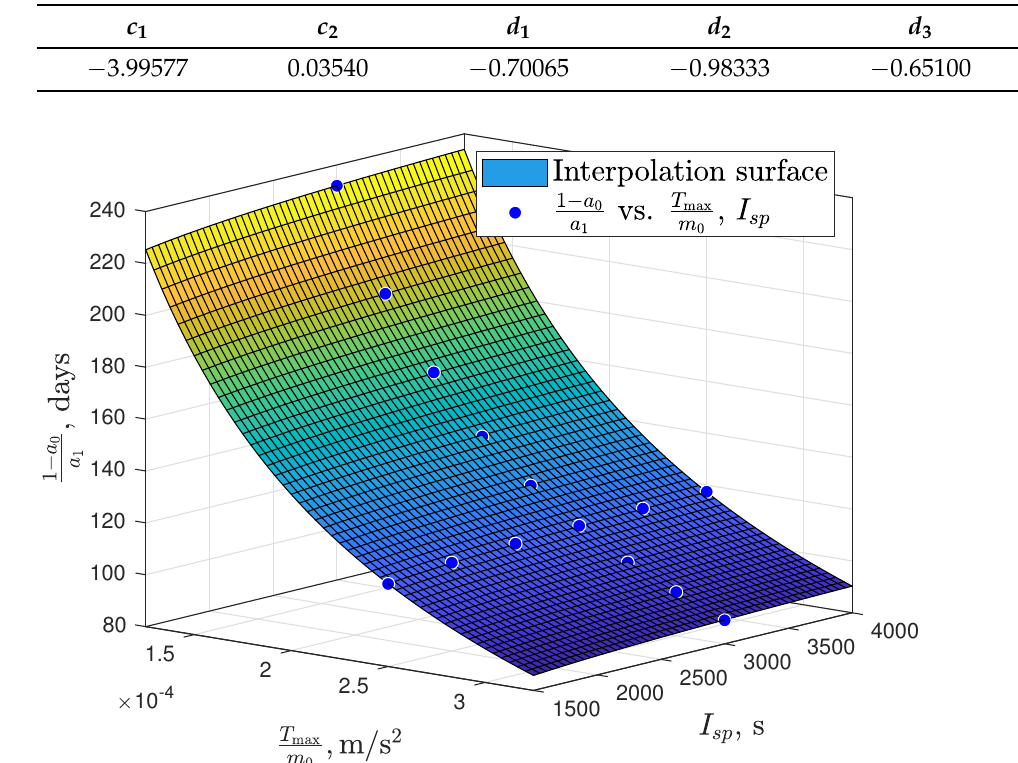
Table 3. Coefficients of the interpolation model.